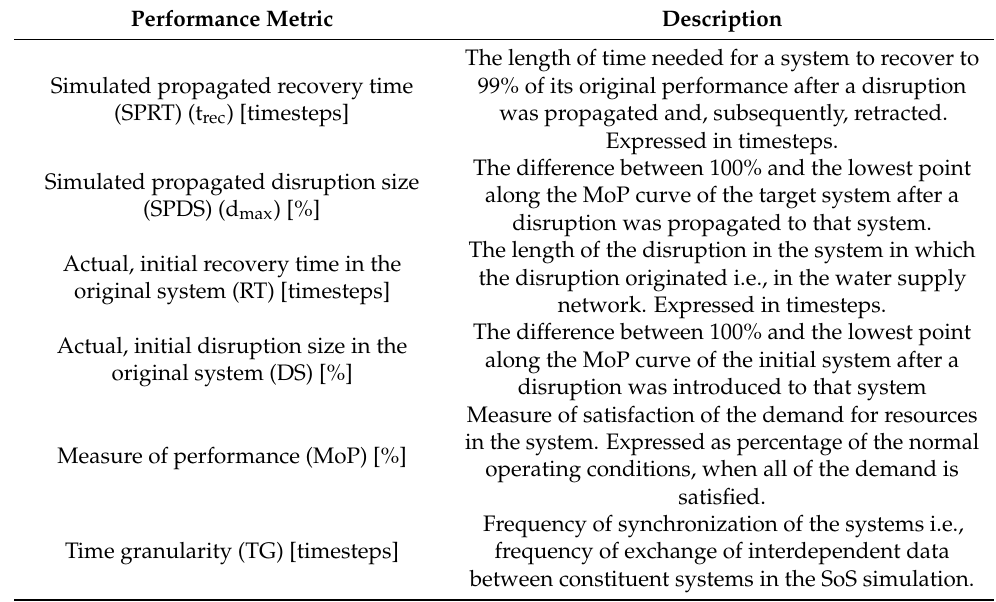
Table 2. Performance metrics and variables. Performance Metric